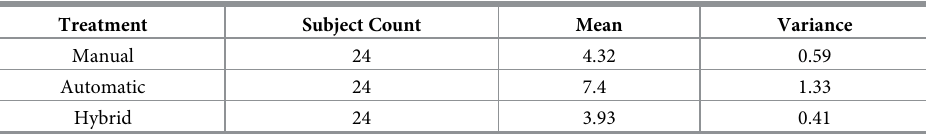
Table 19. Data summary—Viewpoint